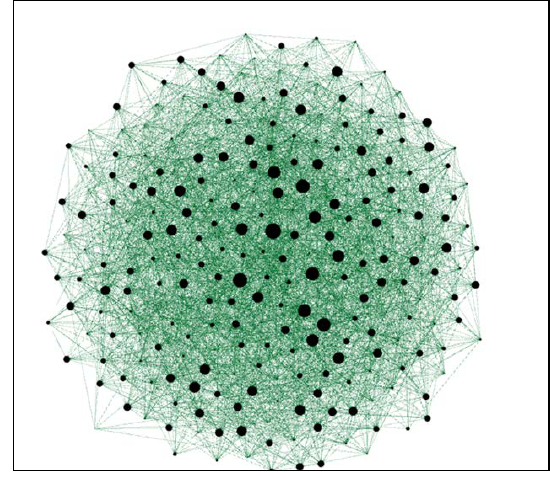
Fig. 1 An example of graph for simulation and metrics calculation, generated by Gephi program